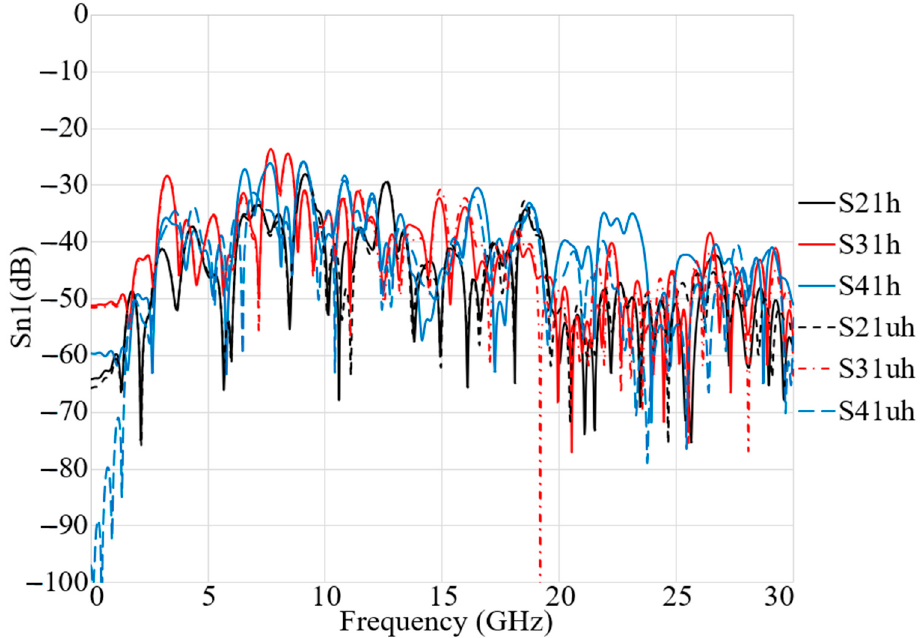
Figure 11. Simulated setup of the antenna array elements in on-body conditions (with (uh) and without (h) tumour).